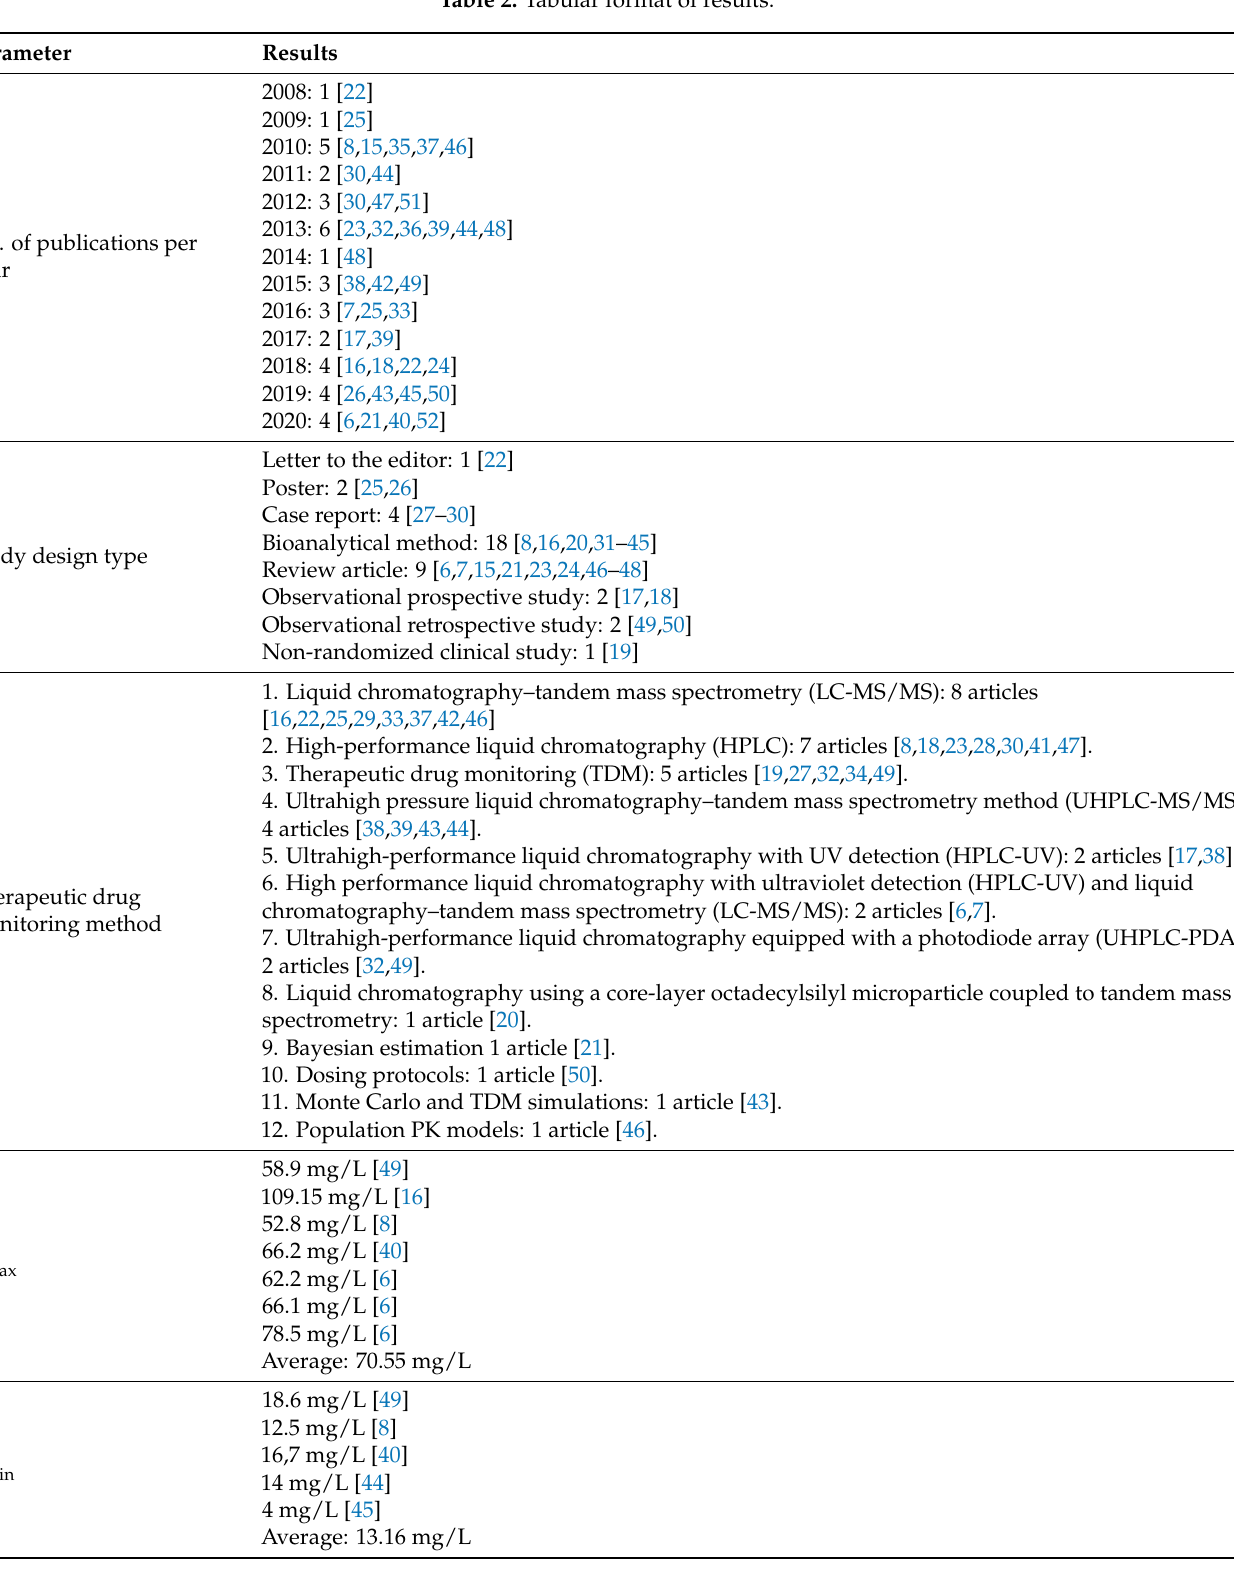
Table 2. Tabular format of